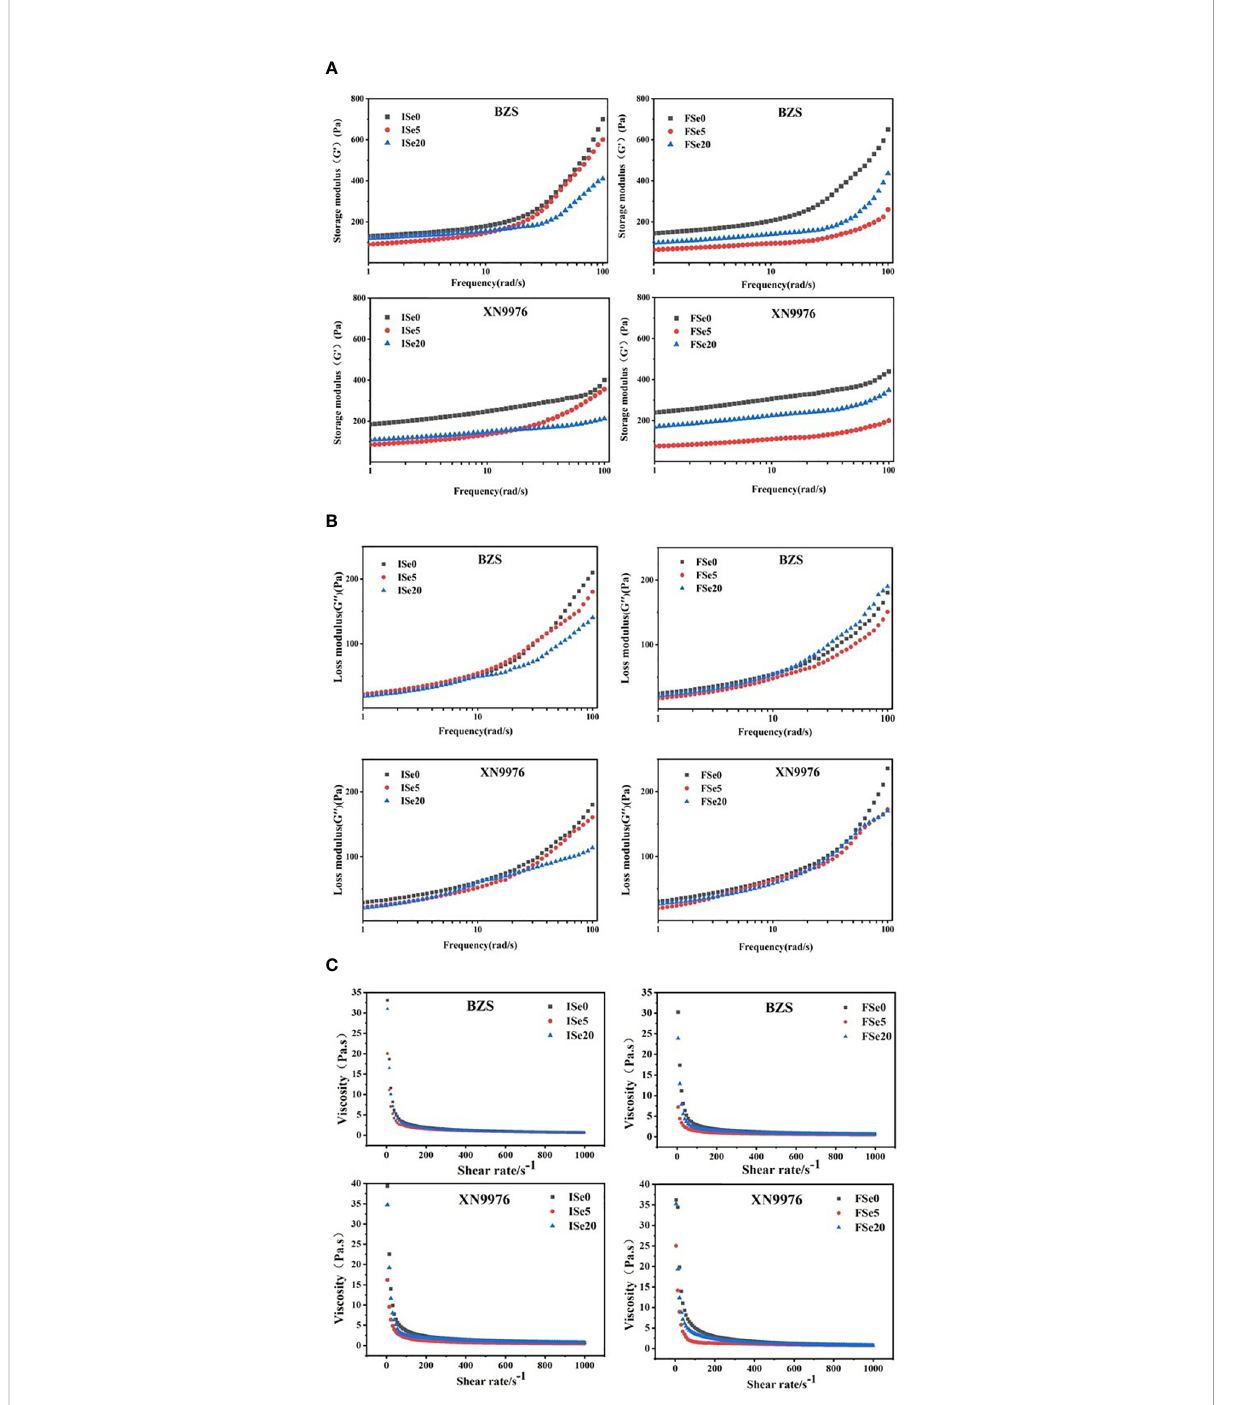
FIGURE 4 (A, B) Curves of storage and loss modulus of common buckwheat starch with frequency under different selenium treatment levels; (C) The static rheology of common buckwheat starch under different selenium treatment